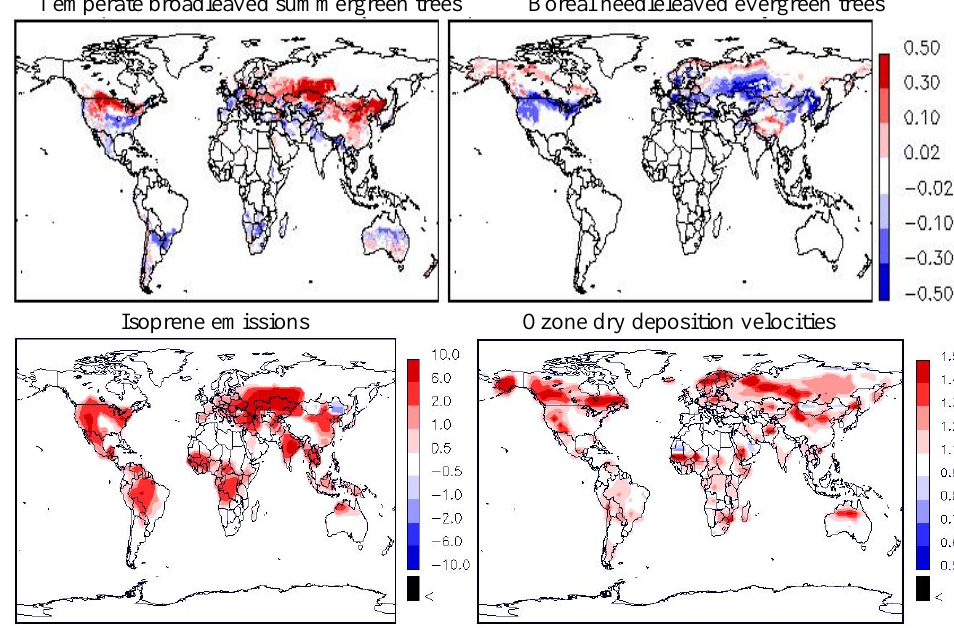
Figure 2. Model calculated 2000-2100 changes in (upper left) areal fractional coverage of temperate Fig. 2. Model calculated 2000–2100 changes in (upper left) areal fractional coverage of temperate broadleaved trees, (upper right) boreal broadleaved trees, (upper right) boreal needleleaved trees, (lower left) isoprene emissions showen as needleleaved trees, (lower left) isoprene emissions showen as differences (in 10 11 atmos Ccm − 2 s − 1 ) , (lower right) dry deposition velocities differences (in 10 11 atmos C cm -2 s -1 ), (lower right) dry deposition velocities of ozone shown as ratio. of ozone shown as ratio. Isoprene emissions and ozone dry deposition are based on Northern Hemisphere summer (June–August) values. Isoprene emissions and ozone dry deposition are based on northern hemisphere summer (June- Color scales are saturated at maximum August) values. Color scales are saturated at maximum values.